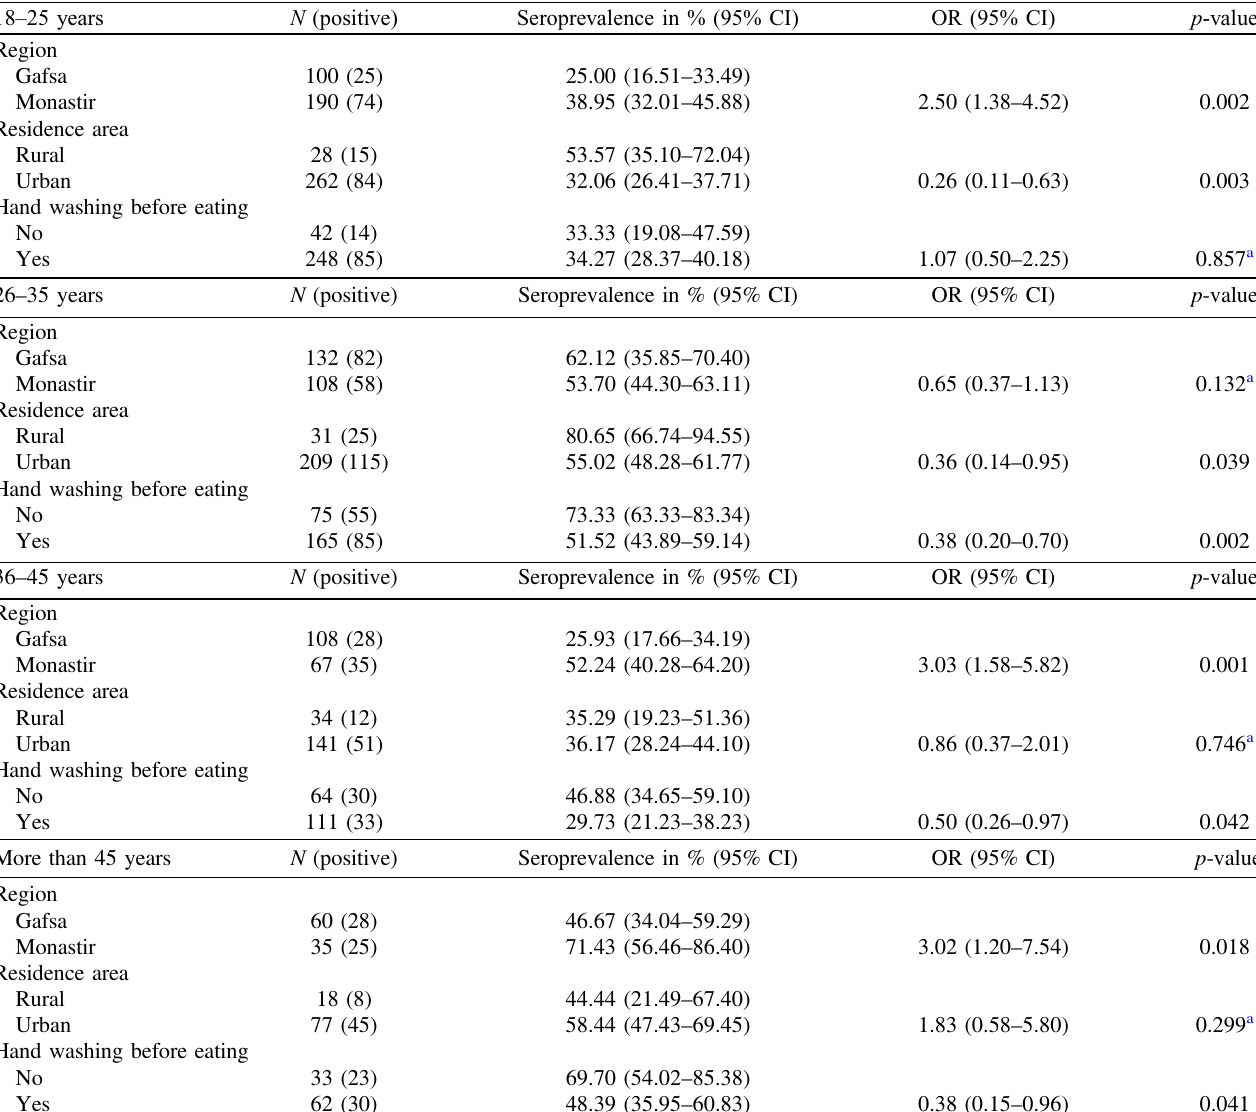
Table 3. Multivariate regression models for Toxoplasma gondii seropositivity based on age